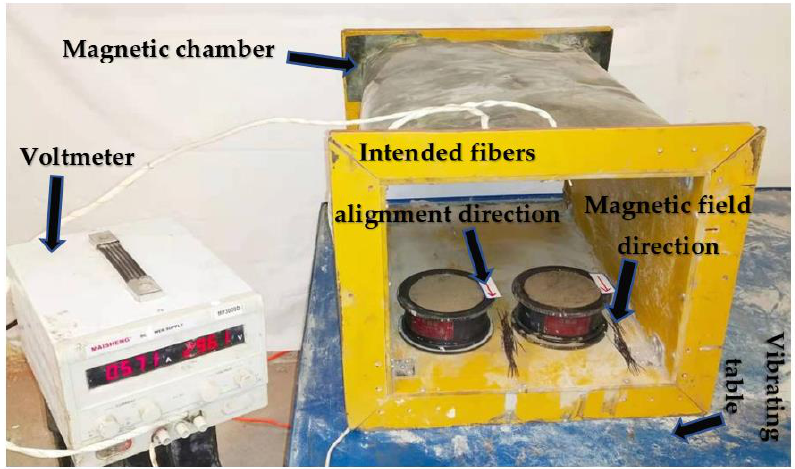
Figure 3. Equipment for the alignment process.